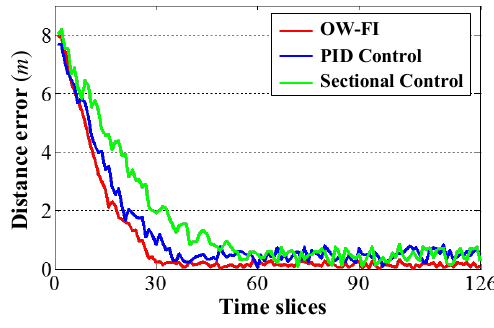
Fig. 17 Convergence rate comparison of three methods in target tracking.